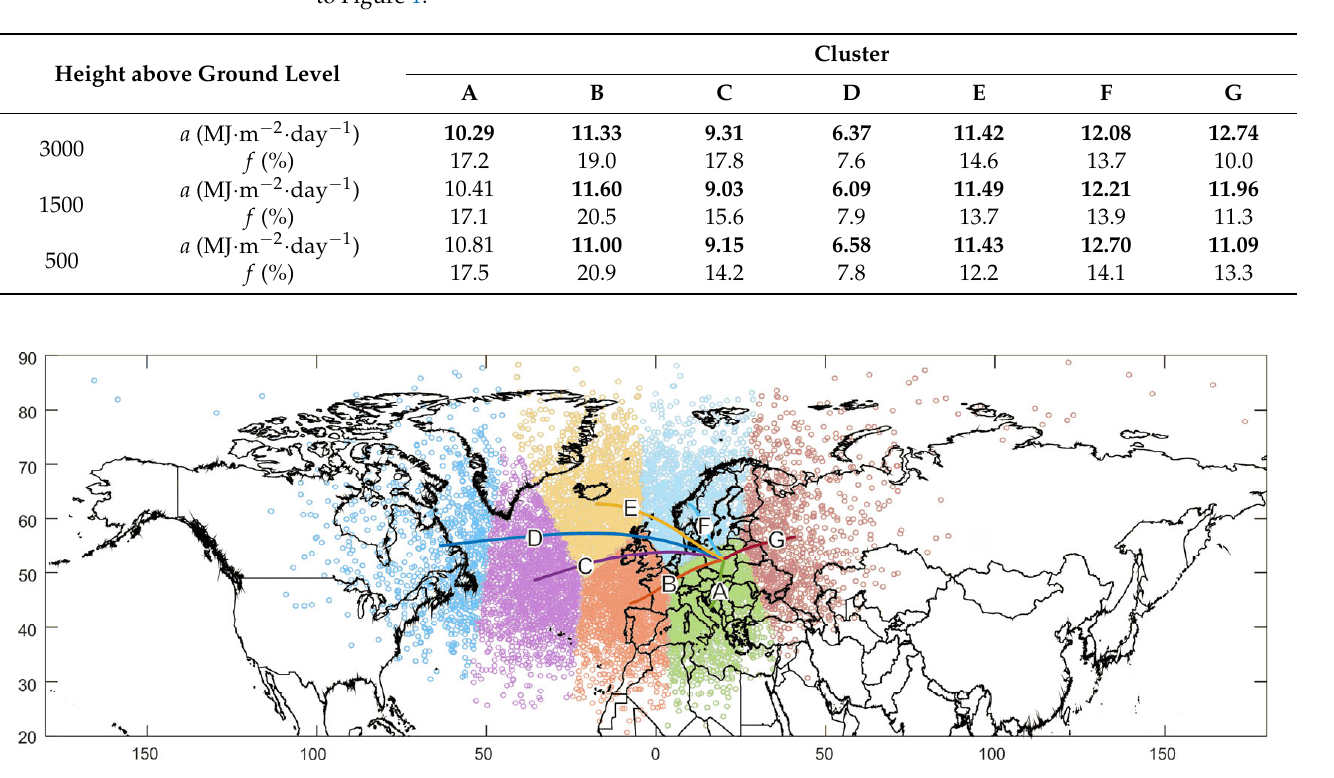
Figure 2. Averaged 72 ‐ h backward trajectories in 7 clusters ending at the grid point 52.5° N, 20° E at 12:00 UTC at 3000 m above ground level, during the period 1986–2015 and clustered starting points of all backward trajectories in the period 1986–2015.